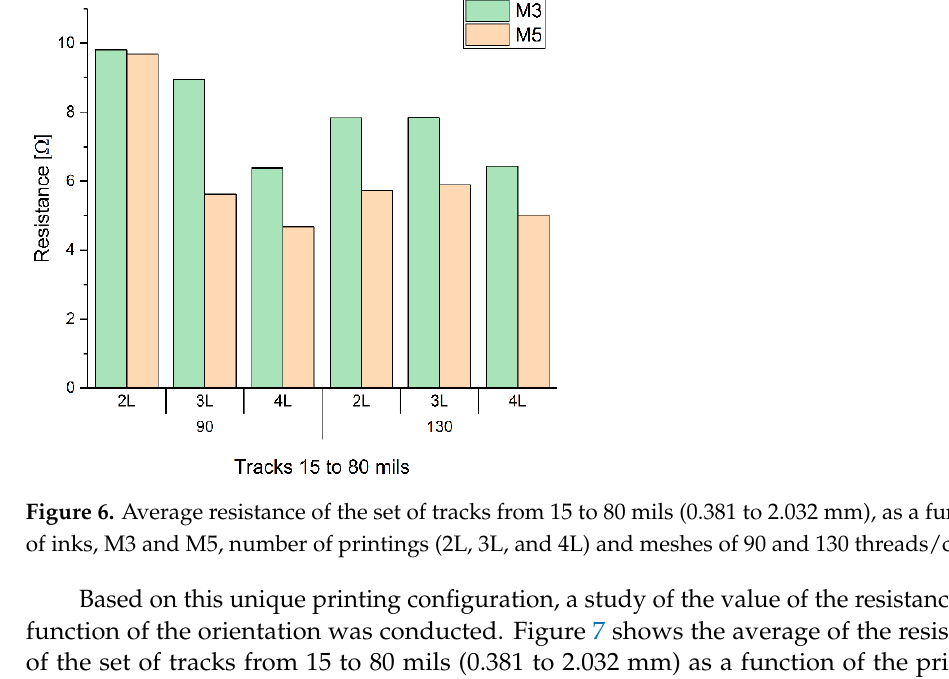
Figure 8. Resistance of each track from 15 to 80 mils (10.381 to 2.032 mm) printed with M5 ink, three layers, and 90 threads/cm mesh. 3.2.2. Dimensional Parameters A fundamental parameter in the development of electronic circuits is the resolution of the track width (TW) obtained in the printing. Several factors can influence this param ‐ eter: First, the type of ink due to the particle size it contains. Mateprincs does not give exact information about the particle size but indicates that it is less than 10 μ m; Second, the mesh of the screen, since the greater number of the mesh, the higher the resolution obtained; Third, the number of printed layers, since the greater number of layers, the higher the width obtained. From the results, the average variation of the track width depending on the orienta ‐ tion and for tracks between 15 and 80 mils (0.381 and 2.032 mm) is 6.14% for 0°, 1.09% for 45°, 6.47% for 90°, and 5.26% for 315°. These data coincide with the average resistance of the set of tracks from 15 to 80 mils (0.381 to 2.032 mm), shown in Figure 7, due to the density of the weft with respect to the warp.